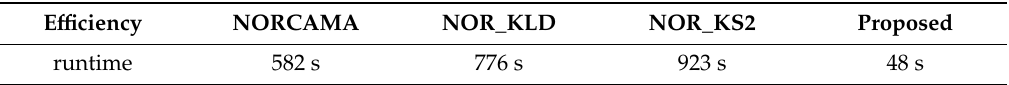
Table 7. Computational time (in seconds) for time-series change detection of 1000 × 1000 × 8 SAR